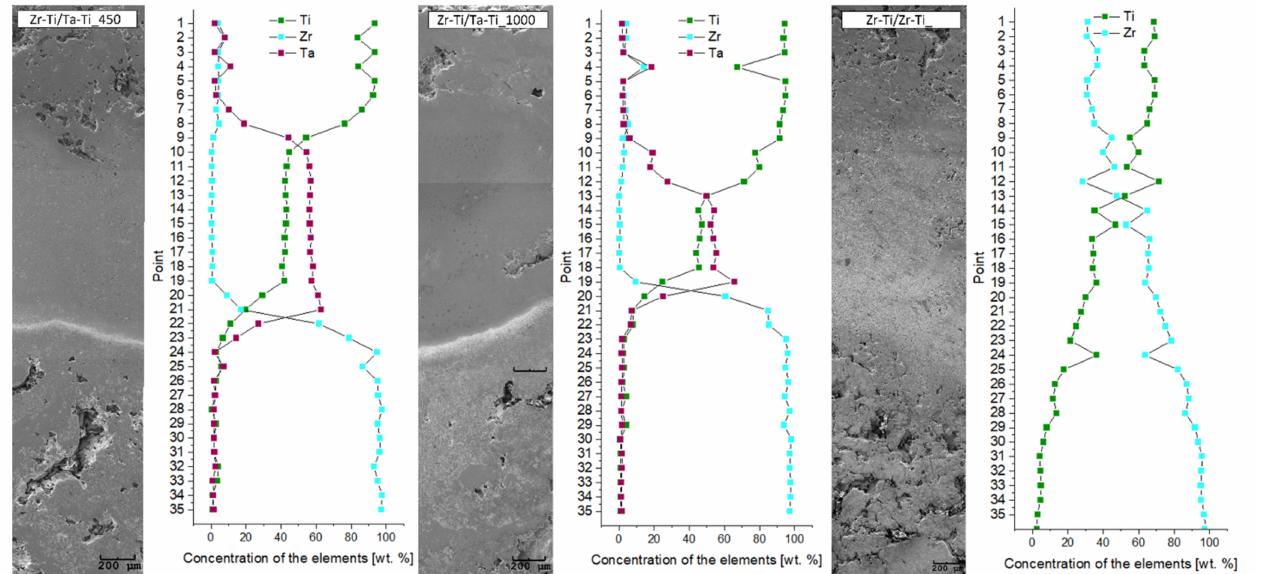
Figure 6. Quantitative analysis of chemical composition, in relation to the location at which the measurement was made. Point 1 is for the outside sample edge and with increase of number the measurement it is closer to zirconium core (point